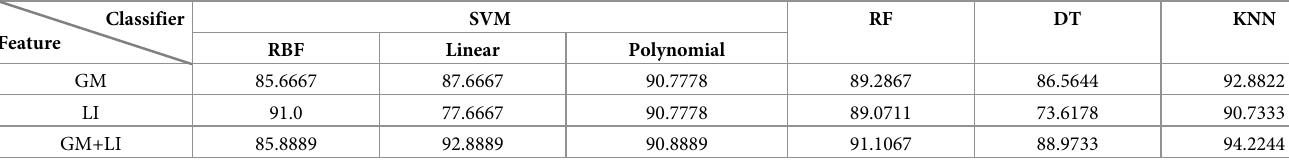
Table 4. Classification results in EMCI versus AD under three kinds of features(%).